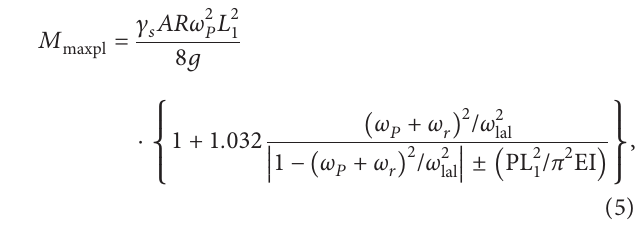
� borehole radius, R w